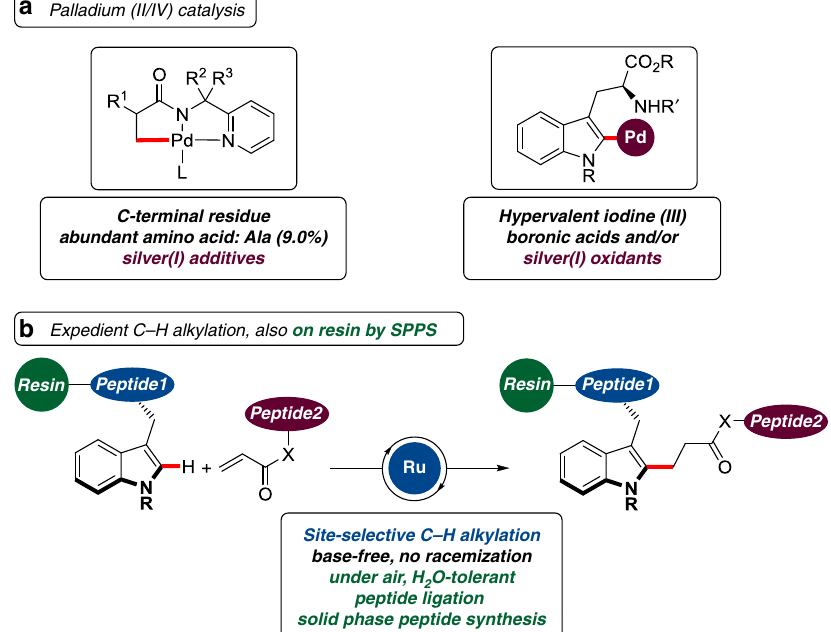
Fig. 1 C – H alkylation for transformative peptide diversi fi cation. a Palladium(II/IV) arylation with reactive, expensive, or toxic reagents; b versatile peptide C – H alkylation/ligation in solution and on solid